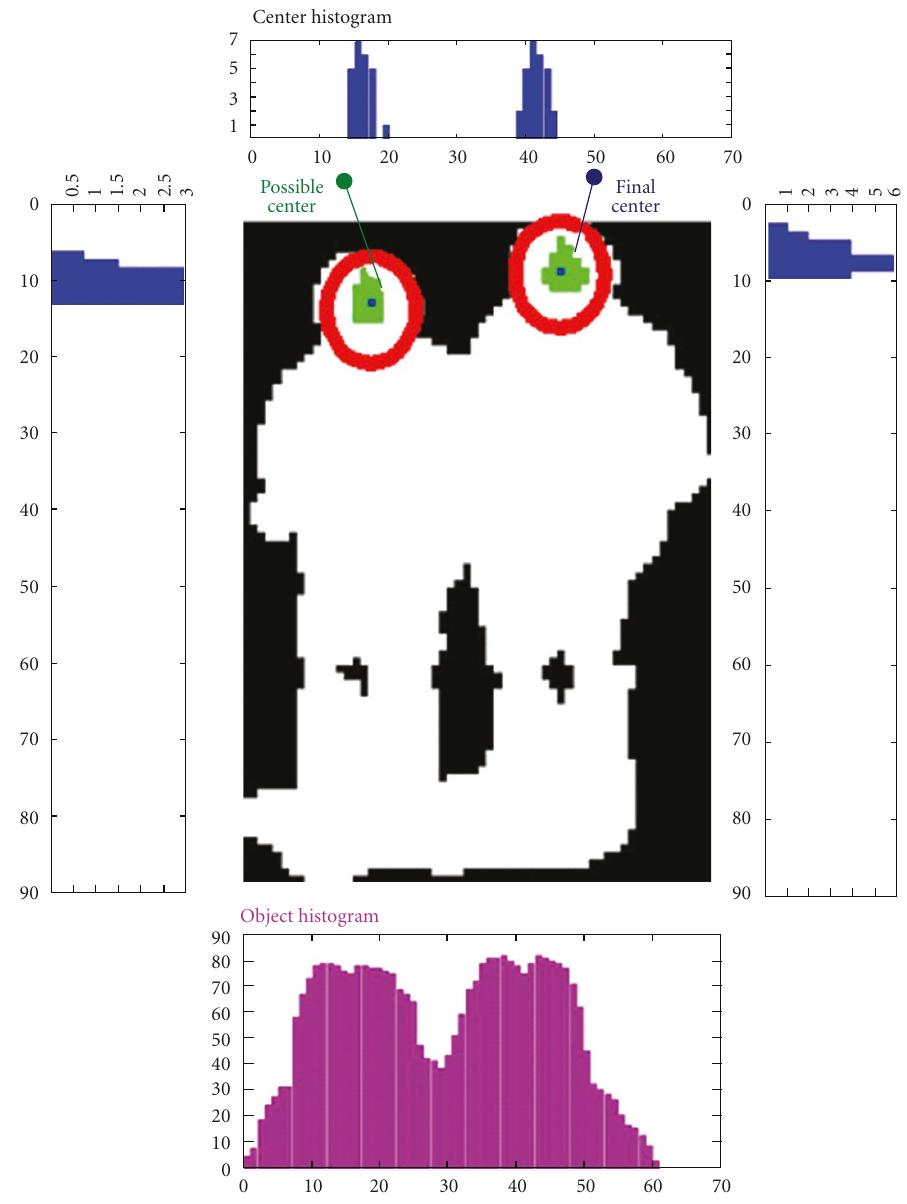
Figure 5: Projection of head